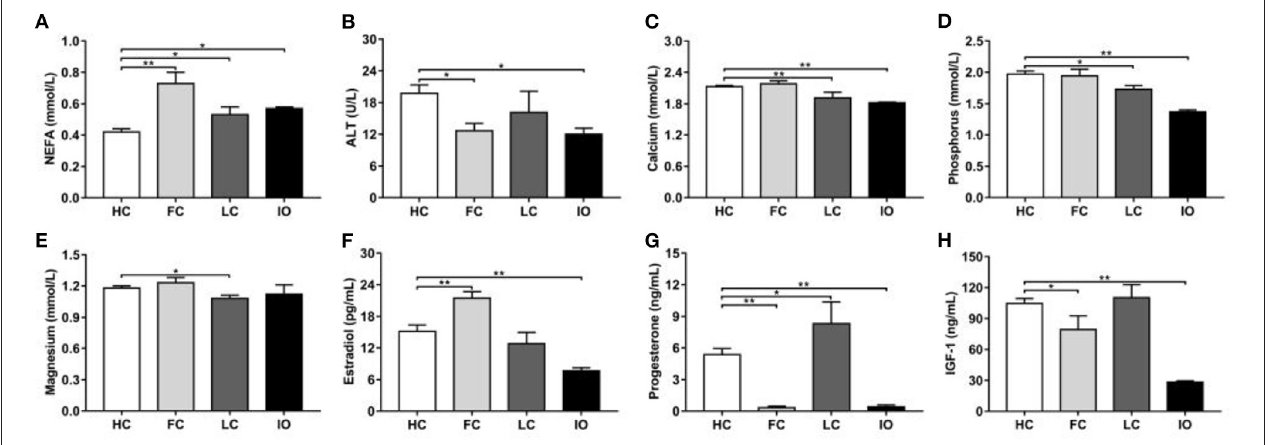
FIGURE 2 | (A–H) Comparison of plasma biochemical indicators between the follicular cysts (FC, n = 18) group, luteal cysts (LC, n = 18) group, and inactive ovaries (IO, n = 18) group and healthy control (HC, n = 22) group, respectively. Note: * P < 0.05, ** P < 0.01 vs. healthy control group. NEFA, non-esterified fatty acids; ALT, alanine aminotransferase; IGF-1, insulin-like growth factor